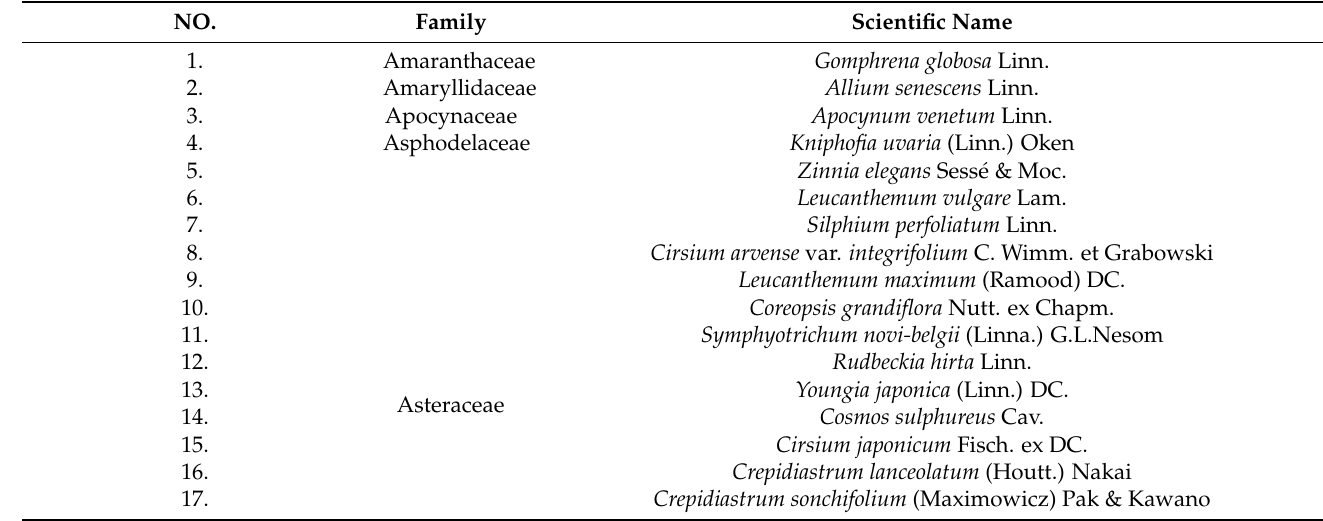
Table A5. The nectar plant species visited by butterflies were recorded in Beijing’ urban parks.